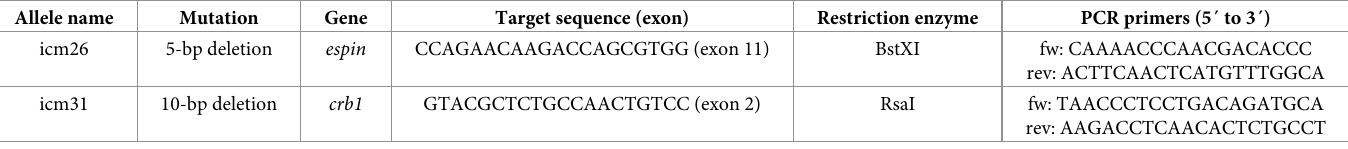
Table 2. Mutant lines generated for this